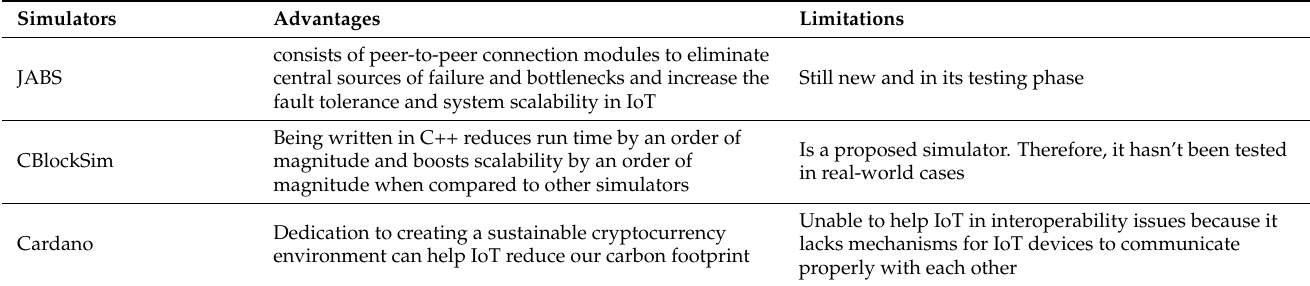
Table 7. Advantages and limitations of potential blockchain simulators for IoT